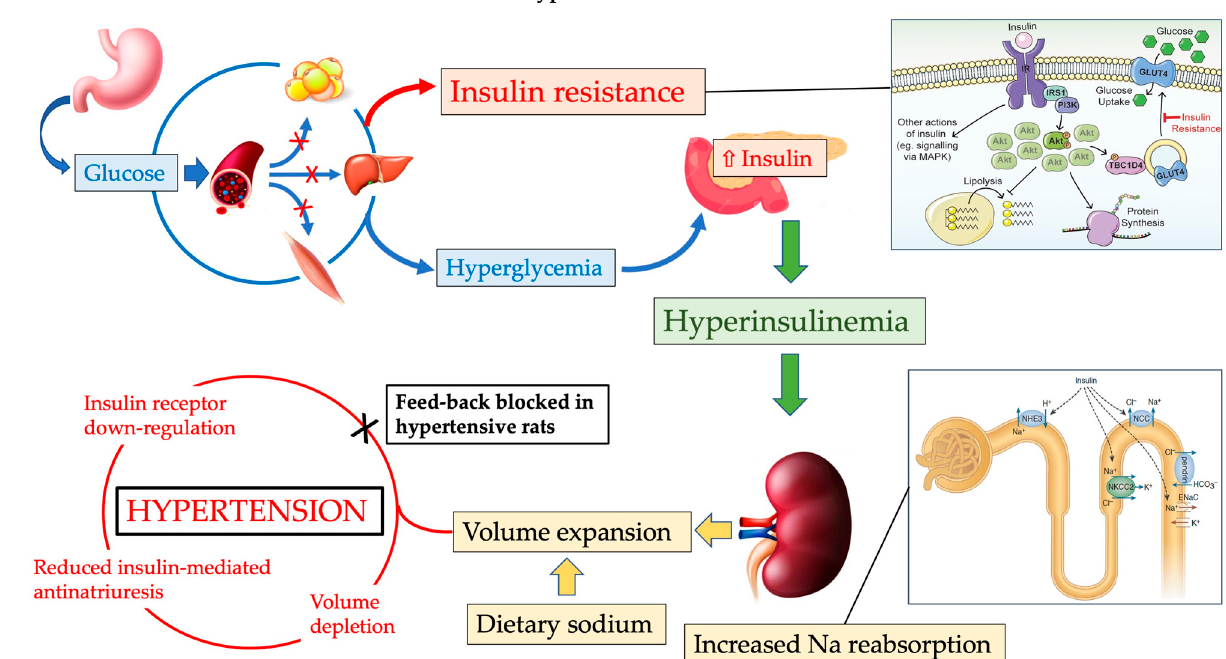
Figure 3. Reduced receptor responsiveness in tissues primarily involved in the metabolic effects of insulin causes decreased glucose uptake and, in turn, leads to a compensatory response of the pancreatic islets with hyperinsulinemia. Excess circulating insulin acting on renal receptors increases sodium reabsorption with extracellular volume expansion. In normal conditions, volume expansion down-regulates renal insulin receptors restoring a normal volume status. In some rat strains of hypertension associated with insulin resistance, the feedback mechanism that reduces insulin-mediated antinatriuresis is defective thereby leading to the persistence of volume expansion and increase in blood pressure.